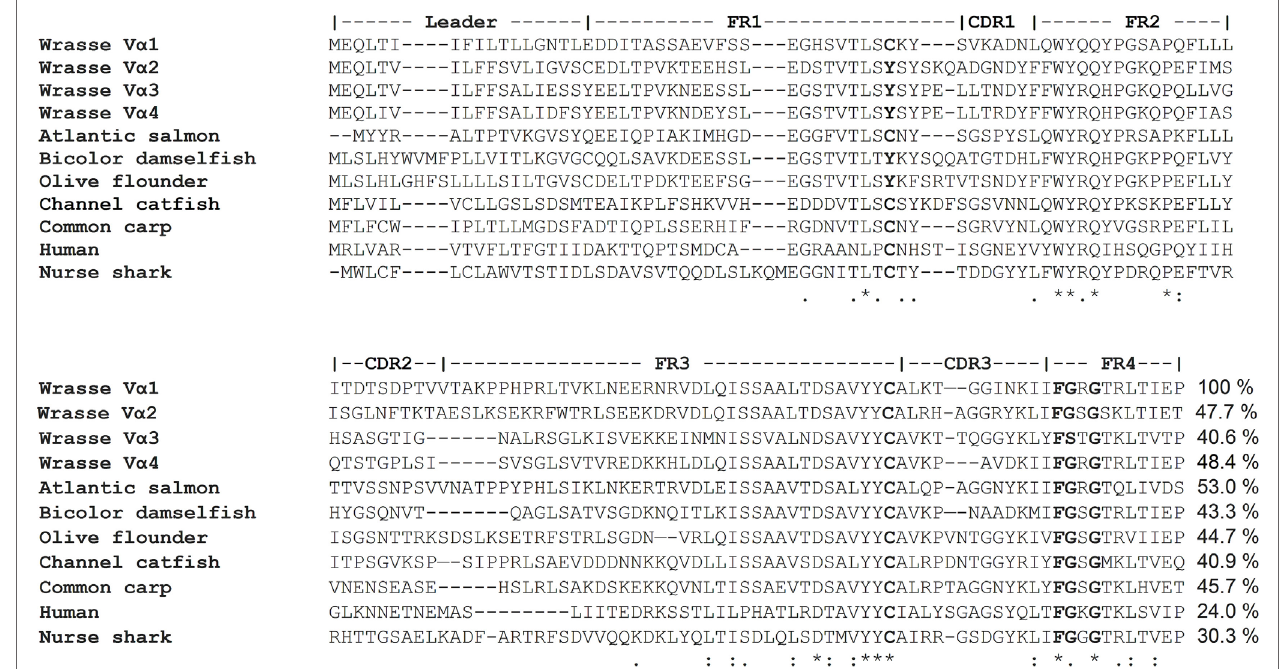
FigUre 2 | Representatives of four TCR α V gene families from Ballan wrasse aligned with corresponding sequences from other species. Amino acid percentage identities between Ballan wrasse V α 1 and the other sequences are indicated at the end. GenBank accession numbers are: Wrasse V α 1 (MG594685), Wrasse V α 2 (MG594679), Wrasse V α 3 (MG594717), Wrasse V α 4 (MG594664), Atlantic salmon (ABO72169.1), bicolor damselfish (AAO88984.1), olive flounder (BAB82535.1), common carp (BAD88980.1), channel catfish (AAD56889.1), nurse shark (ADW95871.1), and human